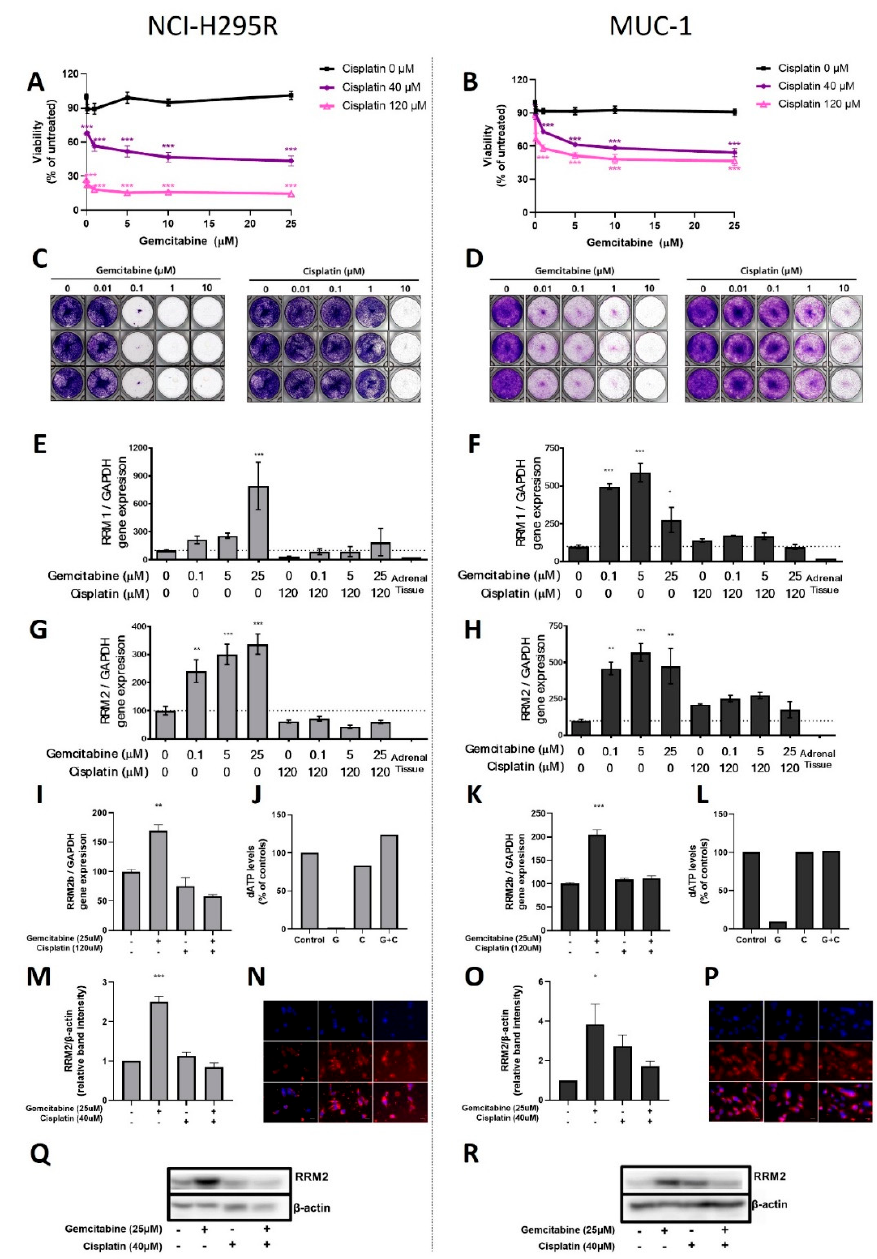
Figure 3. MTT viability assay for different dosages of the drug combination cisplatin and gemcitabine after 24 h of incubation for NCI-H295R ( A ) and MUC-1 ( B ) cell lines. Pictures from NCI-H295R ( C ) and MUC-1 ( D ) clonogenic assays for different concentrations of gemcitabine (left) and cisplatin (right) treatment after 24 h incubation. Real-time PCR analysis of RRM1 for NCI-H295R ( E ) and MUC-1 ( F ), as well as RRM2 ( G , H ) and RRM2B ( I , K ). dATP levels for NCI-H295R ( J ) and MUC-1 ( L ) upon different treatments. Quantification of RRM2 protein levels for NCI-H295R ( M ) and MUC-1 ( O ) and RRM2 immunofluorescence (40x) for NCI-H295R ( N ) and MUC-1 ( P ). A representative Western blot used for RRM2 protein expression quantification in NCI-H295R ( Q ) and MUC-1 ( R ) cells. Stars represent significance vs. nontreated for both treatments (*, p < 0.05; **, p < 0.01; ***, p <